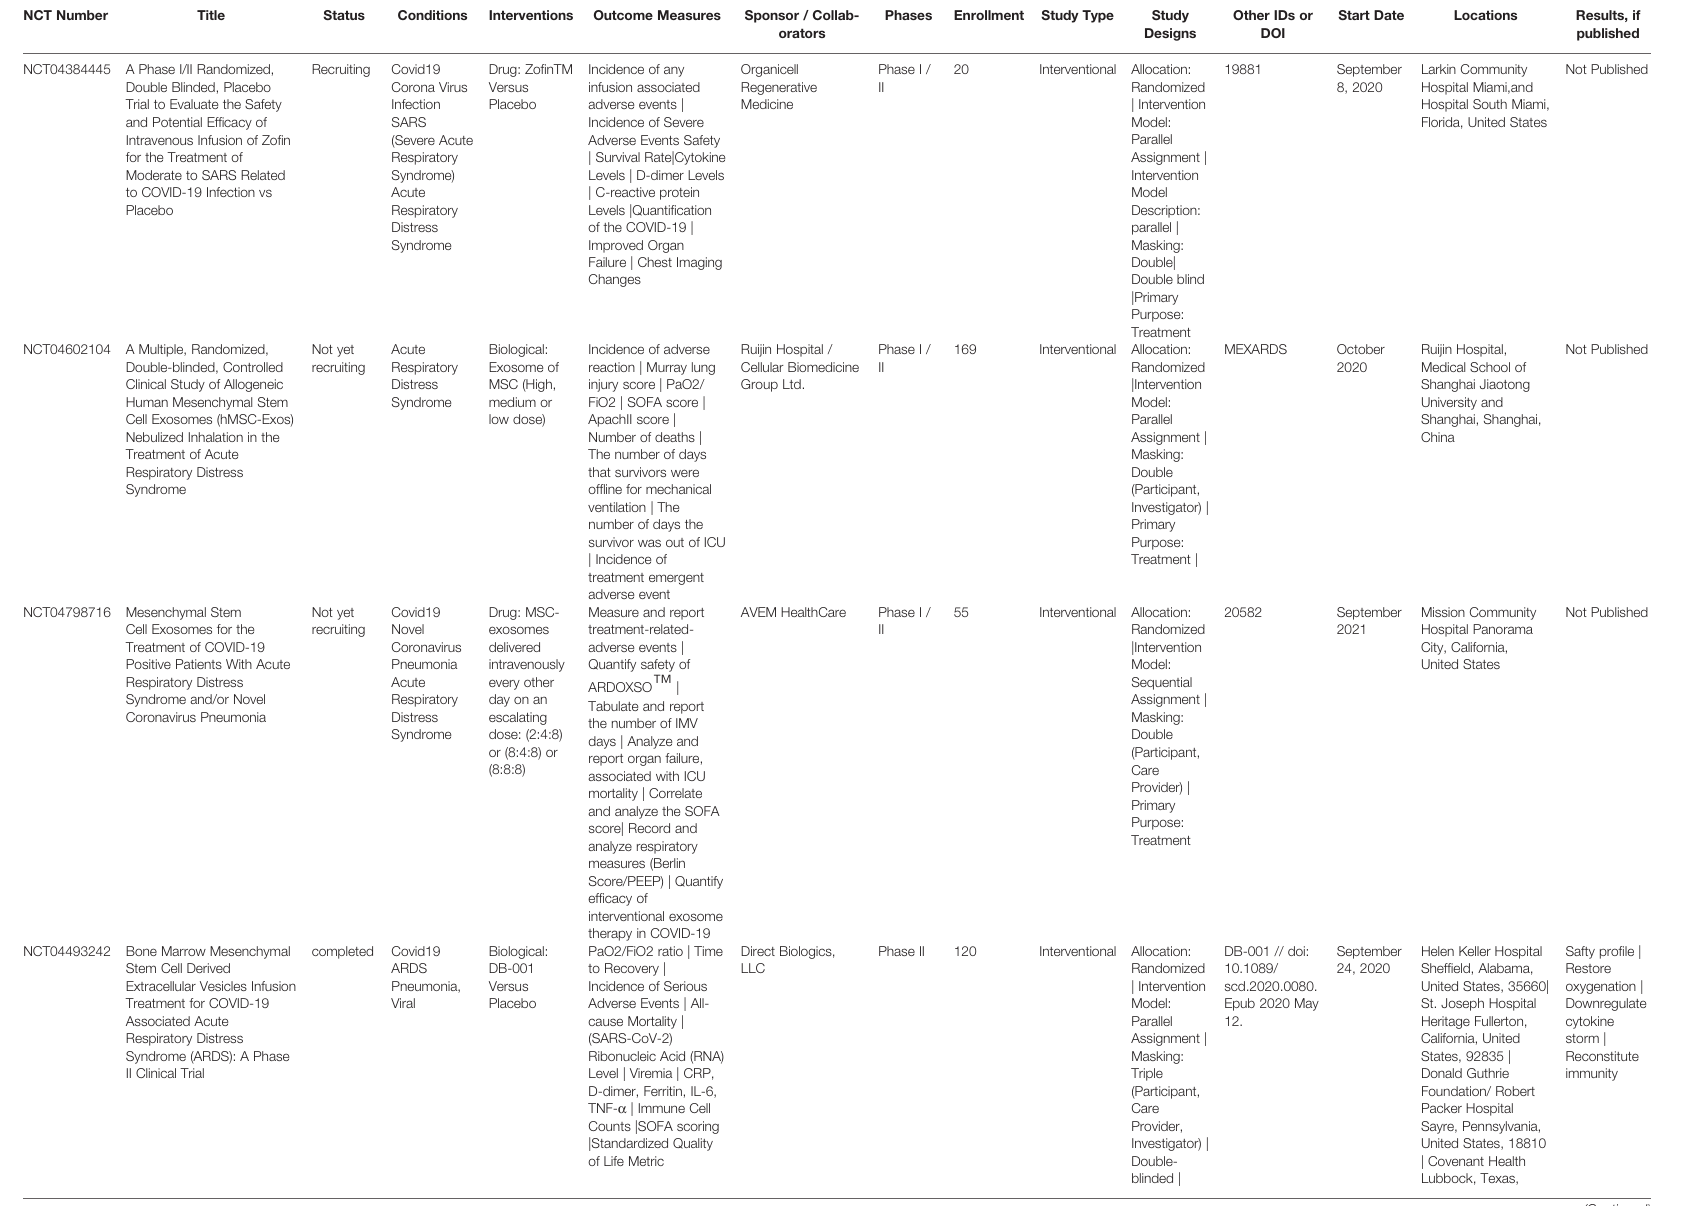
Phases Enrollment Study Type Study